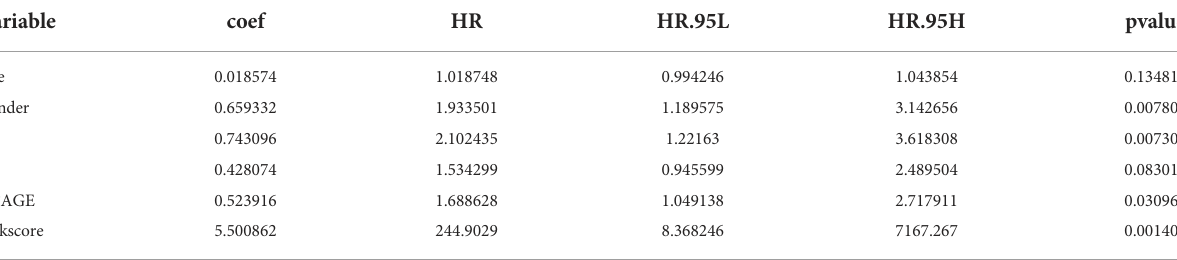
TABLE 6 Prognostic factors associated with LUAD were detected by univariate Cox regression analysis in the TCGA-LUAD cohort.